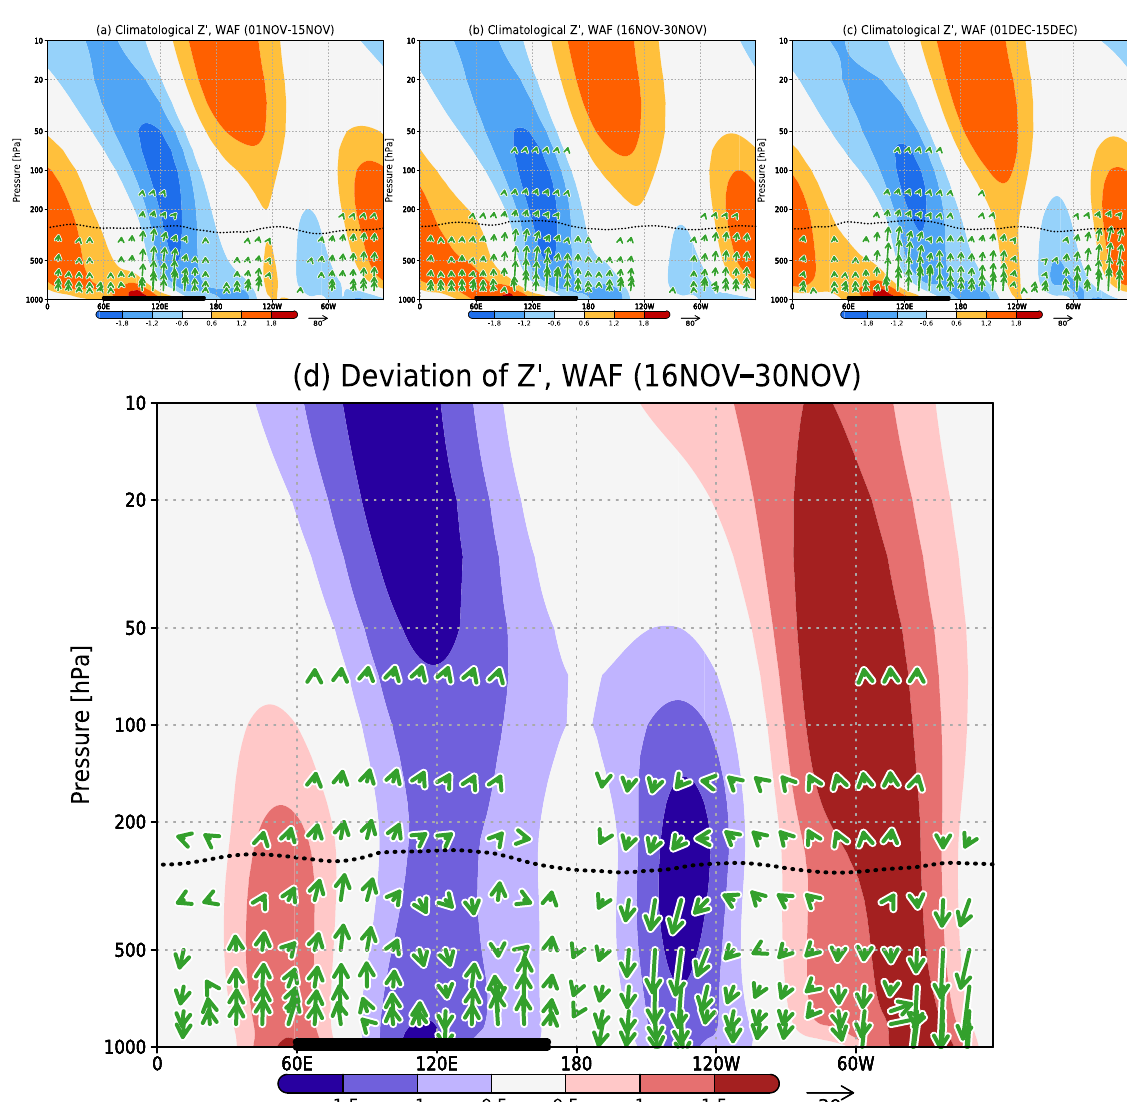
Figure D3. Zonal anomalies of climatological geopotential height (m, color shading) and zonal and vertical components of WAF (10 − 3 m 2 s − 2 , vectors), averaged over latitude 50–70 ◦ N (inside the blue box in Fig. A2) during (a) early November, (b) late Novem- ber, and (c) early December. (d) late November field deviations calculated by Eq. (4) (see Sect. 3.3). The geopotential height is normalized by the standard deviation at each height. The WAF magnitude is standardized by pressure ( p p − 1 s , p s is a standard sea level pressure) and the square of the radius of the Earth (6 . 37 × 10 6 m). The vertical components of the vectors are multiplied by a factor of 500. The black line indicates the latitudinal range for Siberia (60–170 ◦ E). The black dashed line indicates the tropopause height defined by WMO